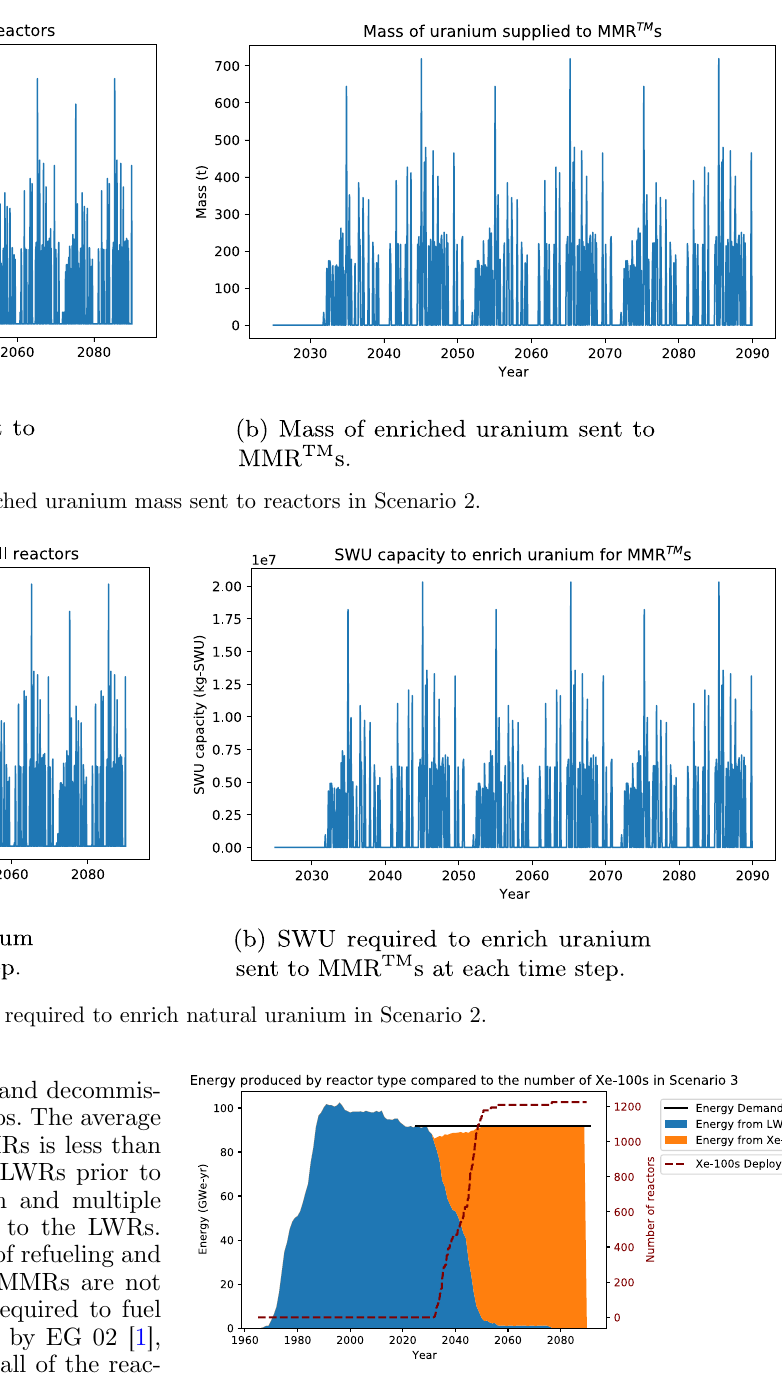
2.07 × 10 6 kg-SWU/month and a maximum of 20.3 × 10